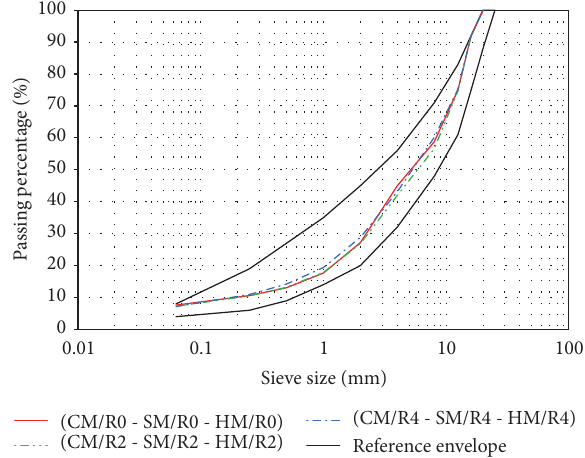
Figure 2: Design grading curves of the hot mix asphalt.